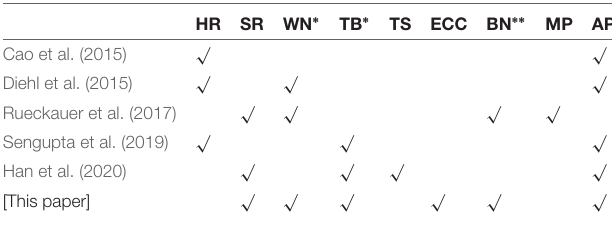
TABLE 1 | Comparison of key technical ingredients (HR, SR, WN, TB, TS, ECC) and workable layers (BN, MP, AP) with the state-of-the-art